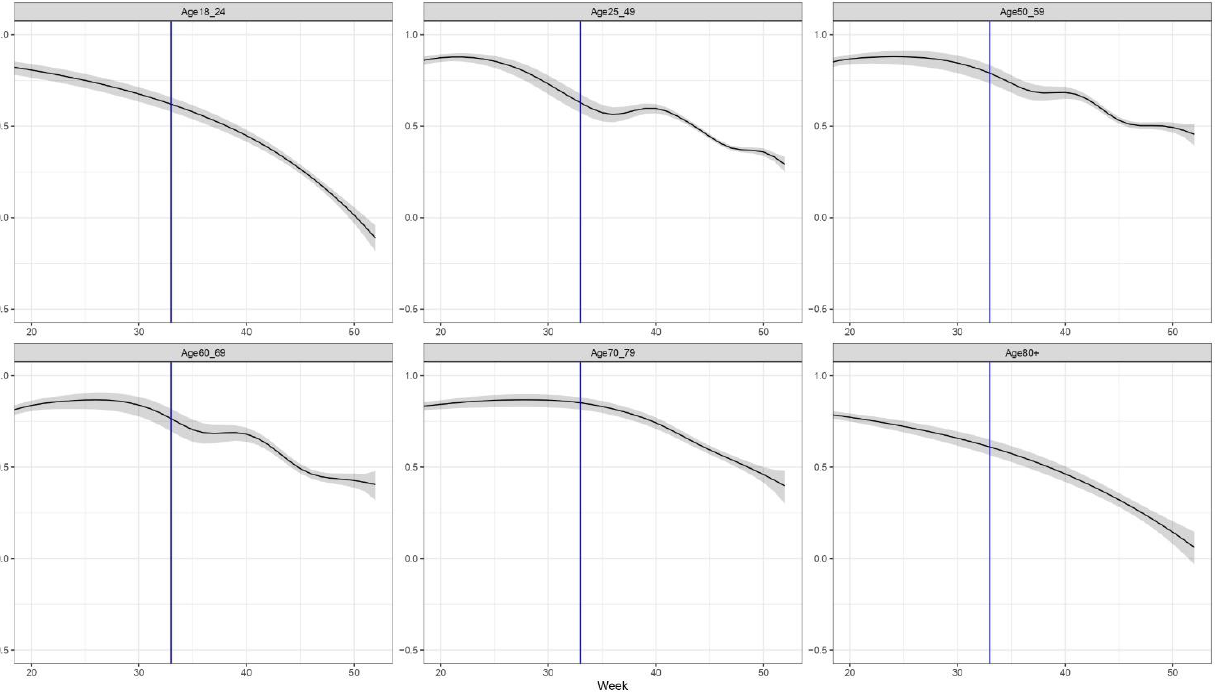
Figure 3. Age- (but not brand-) specific evolution of VE , considering only the primary series (i.e., those who received the third dose are excluded both from the numerator and the denominator).